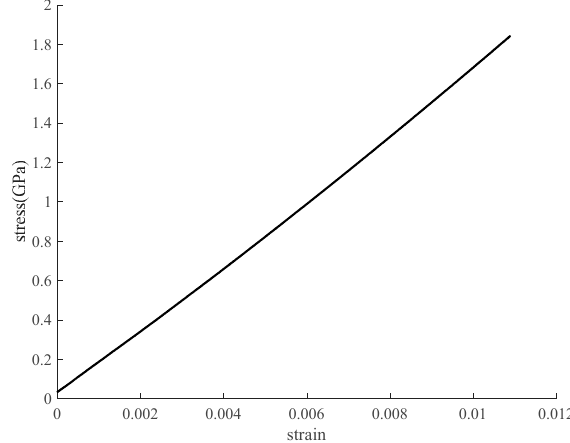
Figure 13. Tensile strength retention of specimens immersed for three months.